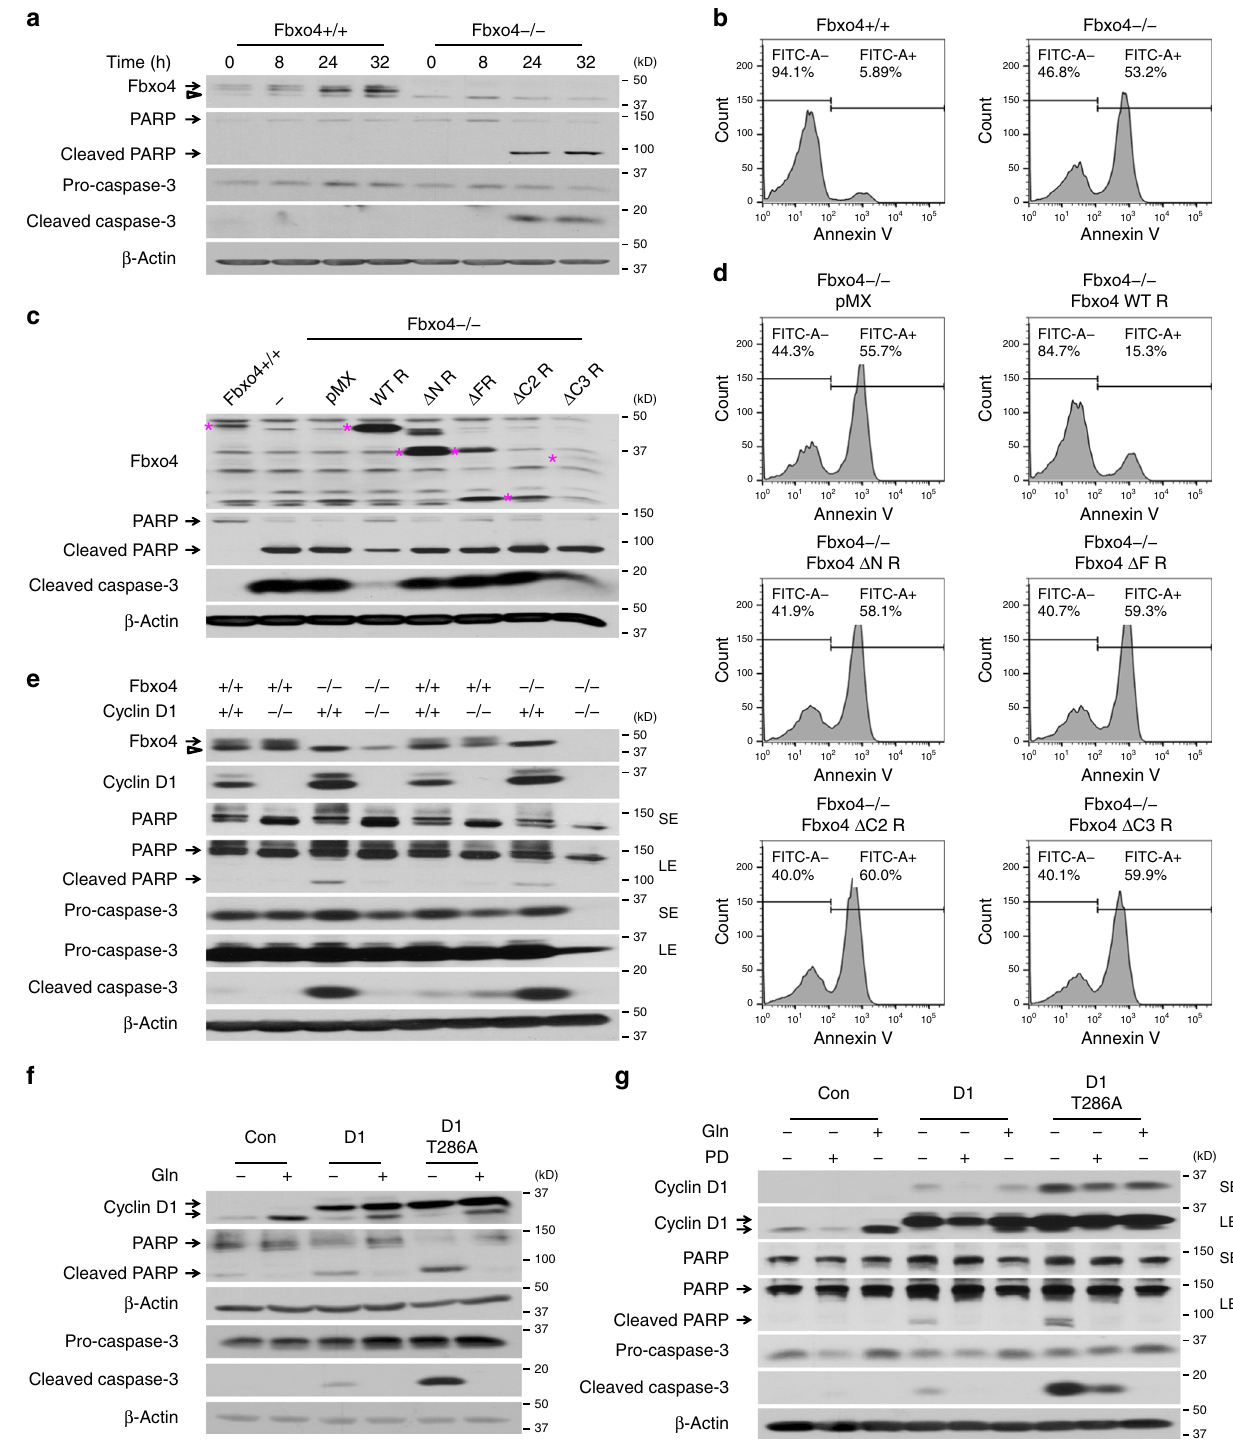
Fig. 1 Dysregulated Fbxo4-cyclin D1 axis leads to Gln-addiction. a Western analysis for cleaved PARP and cleaved caspase-3 in Fbxo4 − / − mouse embryonic fi broblasts (MEFs) following Gln-depletion. b FACS for Annexin V-positive cells following 48 h Gln-depletion. c Western analysis for cleaved PARP and cleaved caspase-3 following 24 h Gln-depletion in Fbxo4 − / − MEFs with ectopic expression of Fbxo4 WT, Δ N, Δ F, Δ C2, or Δ C3. Magenta stars indicate Fbxo4 bands. d FACS for Annexin V-positive cells following 48 h Gln-depletion. e Cyclin D1 knockout antagonizes apoptosis in a Fbxo4 − / − background following 24 h Gln-depletion. In order to show cyclin D1 expression, cyclin D1 blot was performed in medium with Gln, because Gln-depletion reduces endogenous cyclin D1 expression. f Overexpression of cyclin D1 promotes apoptosis in NIH3T3 cells upon 24 h Gln-depletion. g One micromolar PD-0332991 (PD) suppresses apoptosis induced by 24 h Gln-depletion in NIH3T3 cells with ectopic cyclin D1 or D1T286A. SE: short exposure; LE: long exposure. Arrow: speci fi c band; open triangle: non-speci fi c band